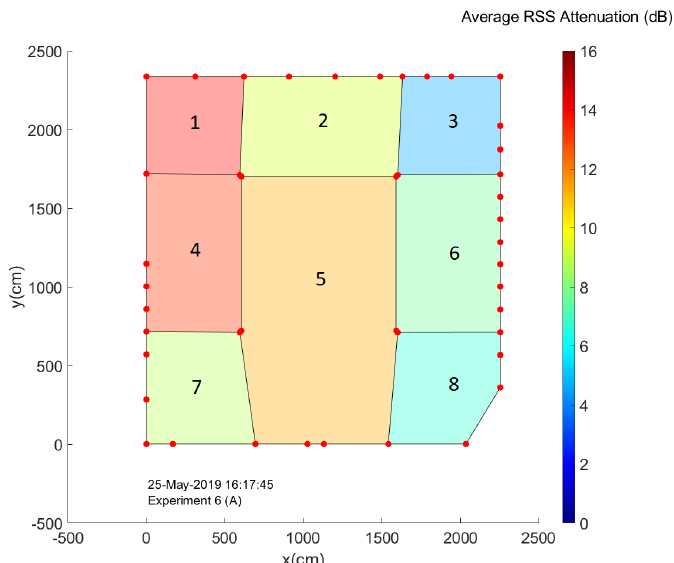
Figure 21. An overview of the manner in which the Nucleus tent environment was divided into 8 subregions. The color of each subregion represents the average RSS attenuation experienced by communication links within this region at the indicated date and time.